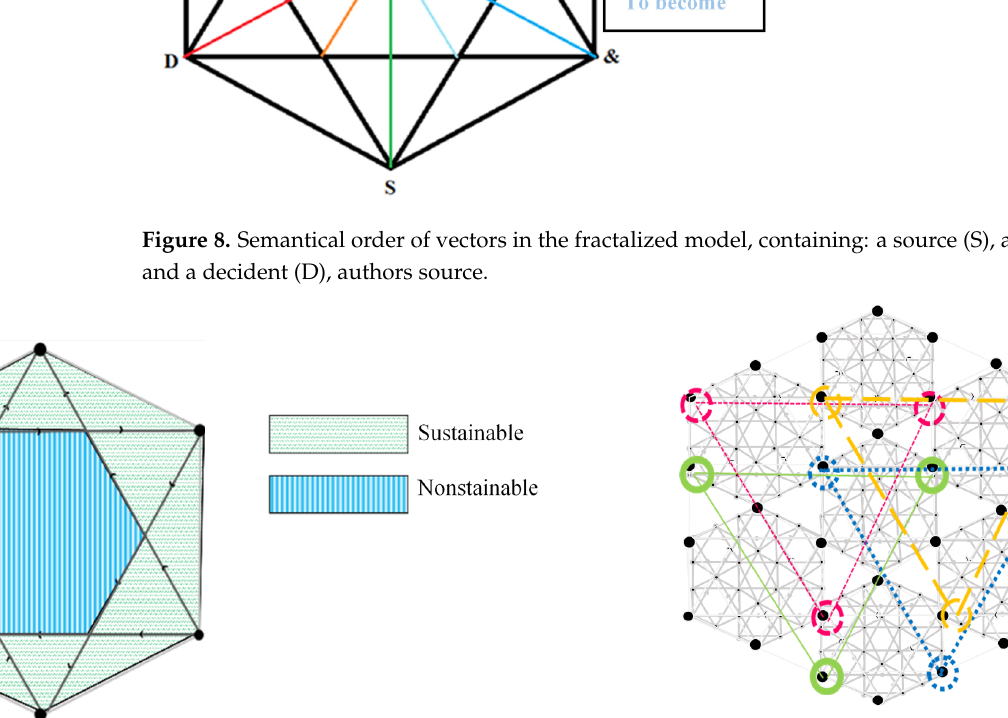
Figure 8. Semantical order of vectors in the fractalized model, containing: a source (S), a sensor (&), and a decident (D), authors source.